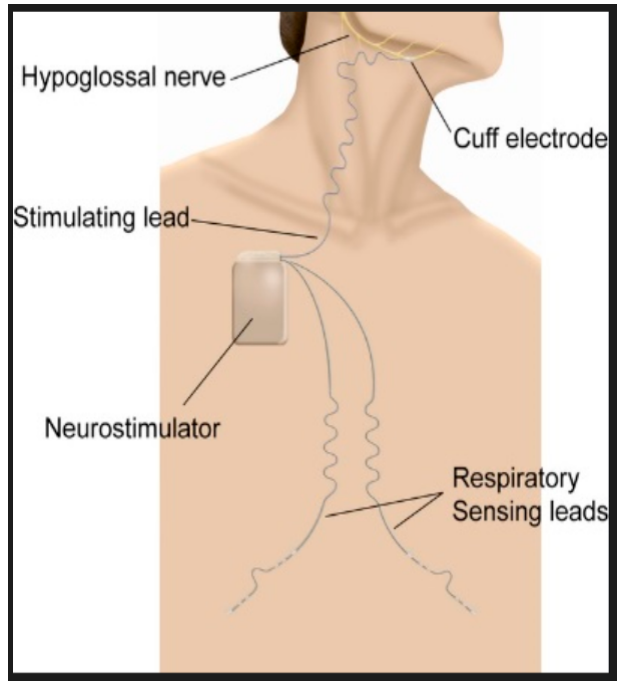
Figure 1. Apnex Medical Inc. (St. Paul, MN, USA).